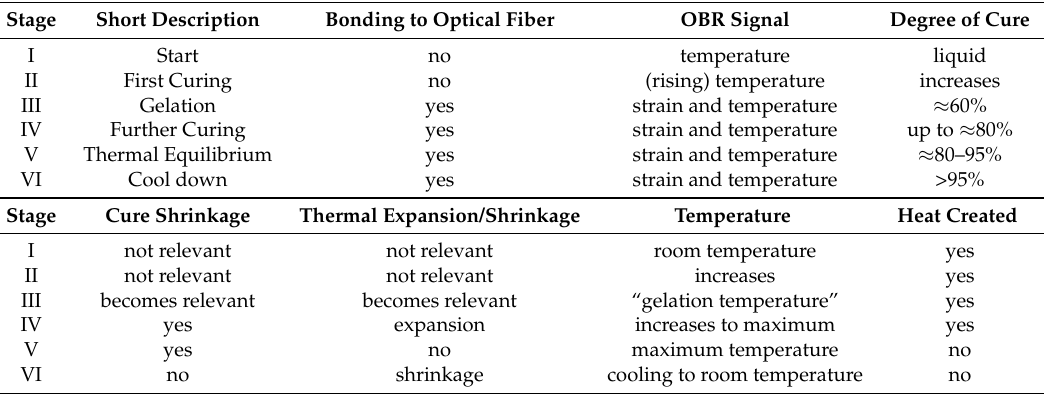
Table 2. Summary of key features during the stages of curing epoxy. “Not relevant” means in this context that it cannot be measured with OBR (early cure shrinkage), or does not contribute to measured strain (early thermal expansion). See the text for